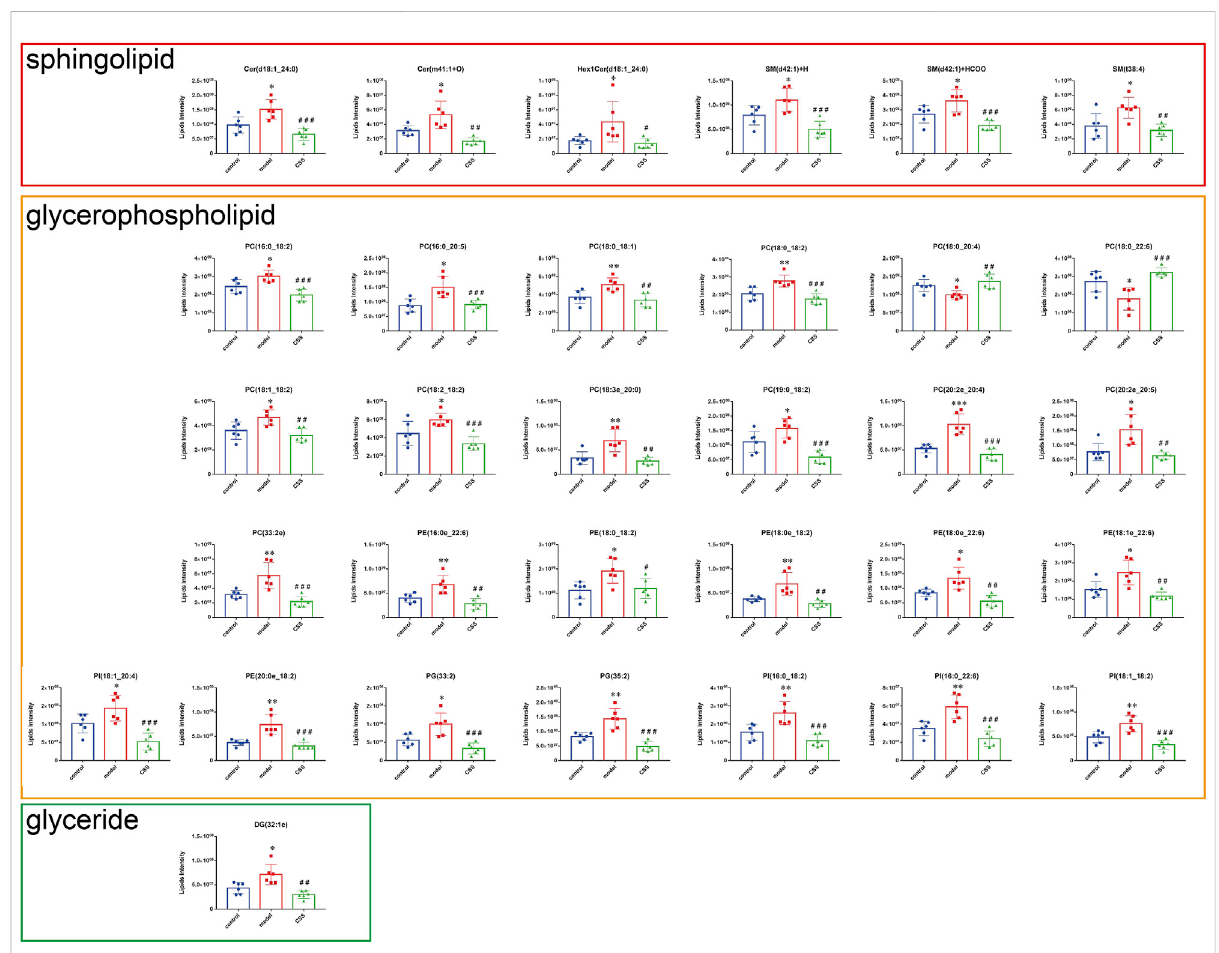
FIGURE 6 Differential expression levels (mean) of 32 differential lipids in different groups. A comparison of the relative intensities of the potential biomarkers in the control, model and CSS groups. (* p < 0.05, ** p < 0.01 and *** p < 0.001 compared with control group; # p < 0.05, ## p < 0.01 and ### p < 0.001 compared with model